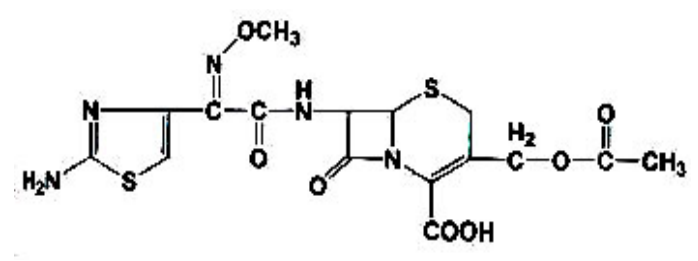
Figure 1. The structure of cefotaxime.